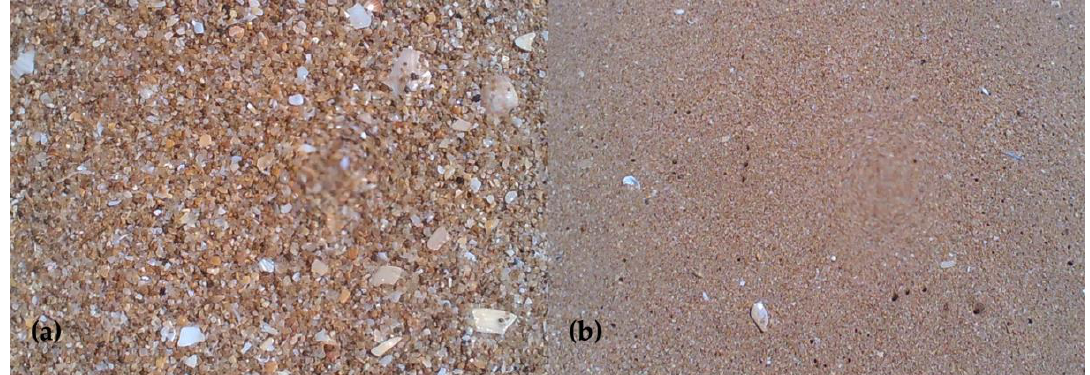
Figure 9. ( a ) Coarse-grained sediments visible on the west side of Praia da Cova Redonda and ( b ) fine-grained sediments visible on the east side of Praia da Cova Redonda.